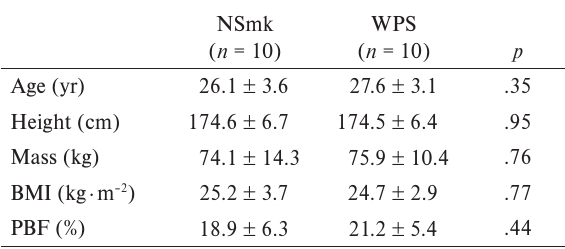
Descriptive characteristics (mean ± SD) of all